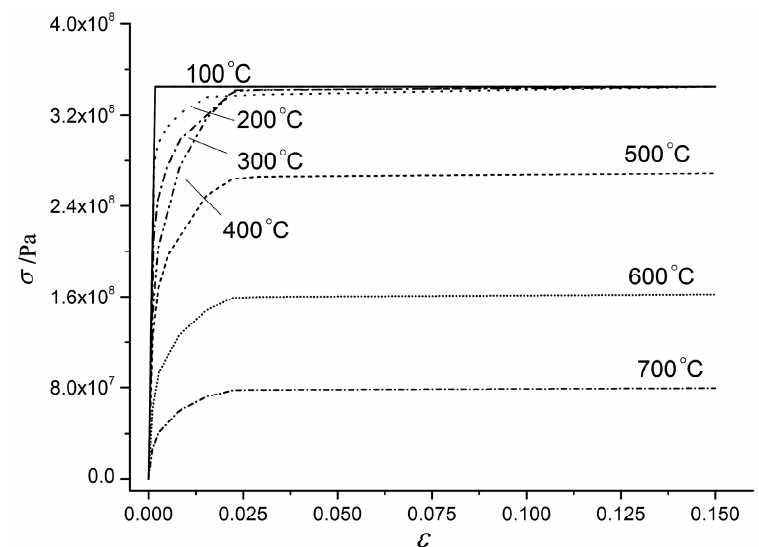
Figure 2. Stress-strain relationship of Q235B steel at different Figure 2. Stress ‒ strain relationship of Q235B steel at different temperatures.